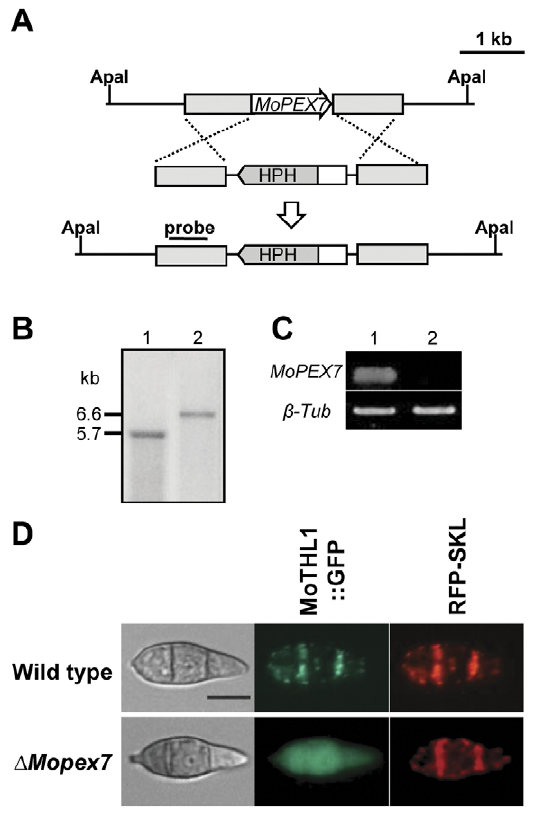
Figure 1. Identification of MoPEX7 T-DNA and deletion of MoPEX7 . (A) Knockout strategy using double-joint PCR. (B) Southern hybridization of D Mopex7 . Genomic DNA was digested with Apa I. About 1 kb upstream flanking region of MoPEX7 was used as probe. Lane 1, wild-type strain KJ201; lane 2, D Mopex7 . (C) MoPEX7 gene expression in the wild type and D Mopex7 with RT-PCR. Lane 1, wild type; lane 2, D Mopex7 . (D) Subcellular localization of the MoTHL1::GFP fusion protein. MoTHL1::GFP containing peroxisome targeting signal 2 was localized in the peroxisome in the wild-type strain KJ201. RFP-SKL (PTS1) was used as positive control. Bar=10 m